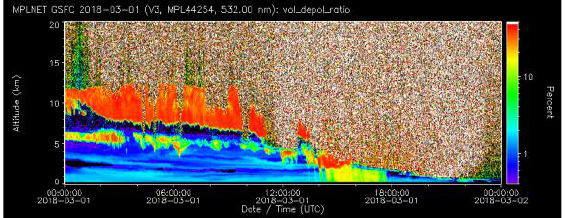
Figure. 1 Depolarization Channel from MPLNET GSFC station on March, 1 st 2018. A rain event is clearly detected from about 1400 to 1800 UTC.